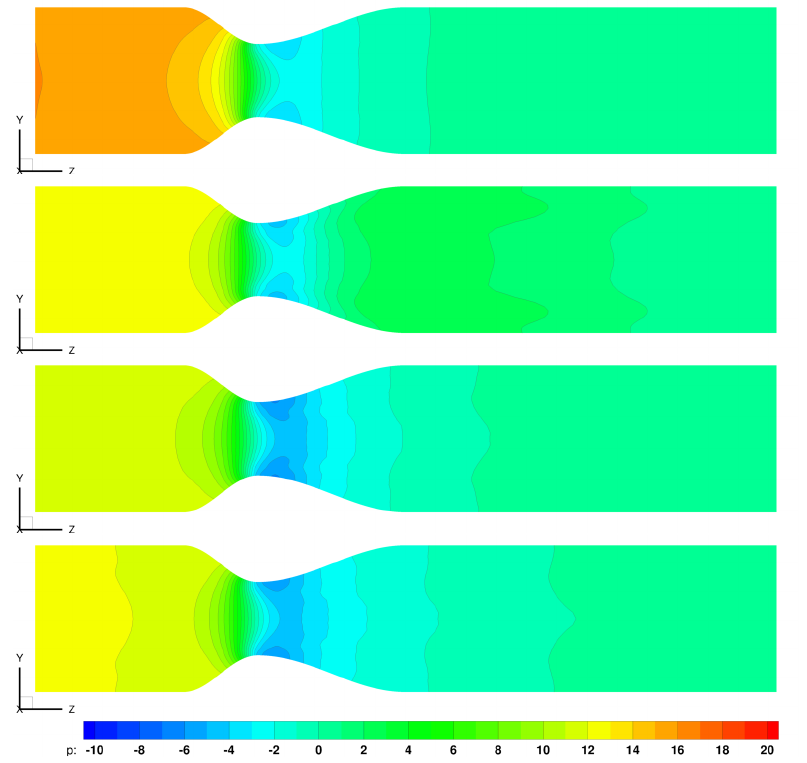
Figure 22. Pressure at flow rate Q = 1.0 cm 3 /s — GOB (top figure) and Johnson–Segalman models for a = − 0.9, a = − 0.8, a = − 0.7 (from the top).